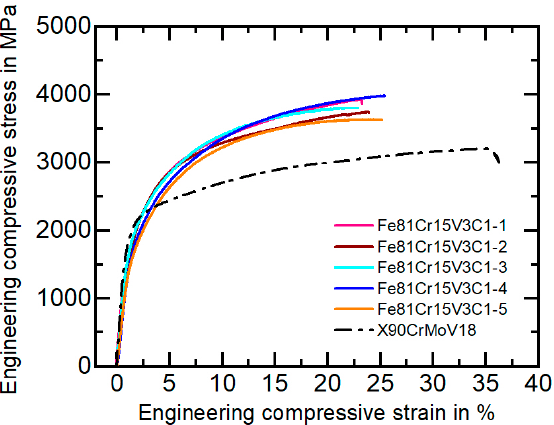
Figure 5. Characteristic engineering stress–strain curves of the studied FeCrVC cast alloy and the reference material X90CrMoV18 under a quasi-static compressive load. Table 3. Mechanical characteristics of the examined alloys measured by compression (offset yield